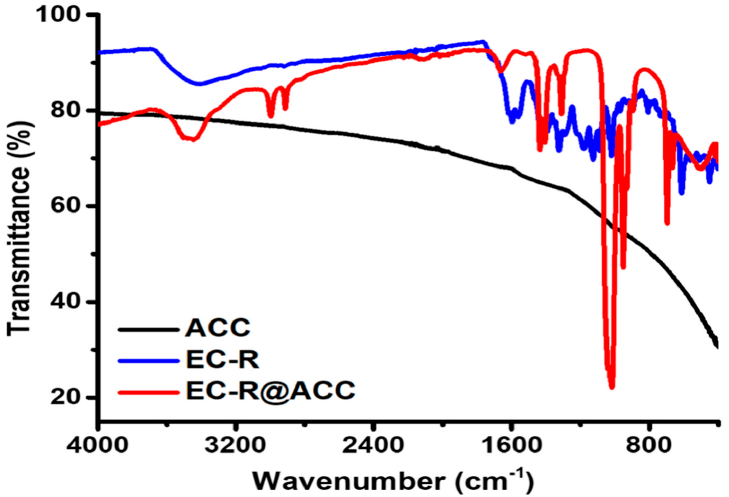
Figure 6. Studies of the ACC, EC-R, and EC-R@ACC photocatalyst by FTIR technique.